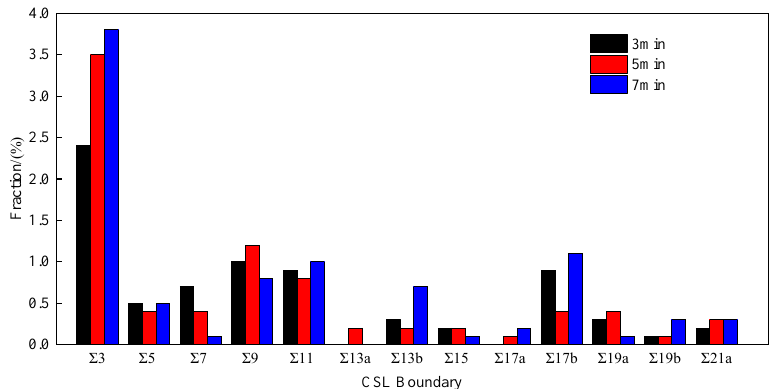
Figure 6. Fraction of CSL boundaries of decarbonized annealing samples along the thickness direction.